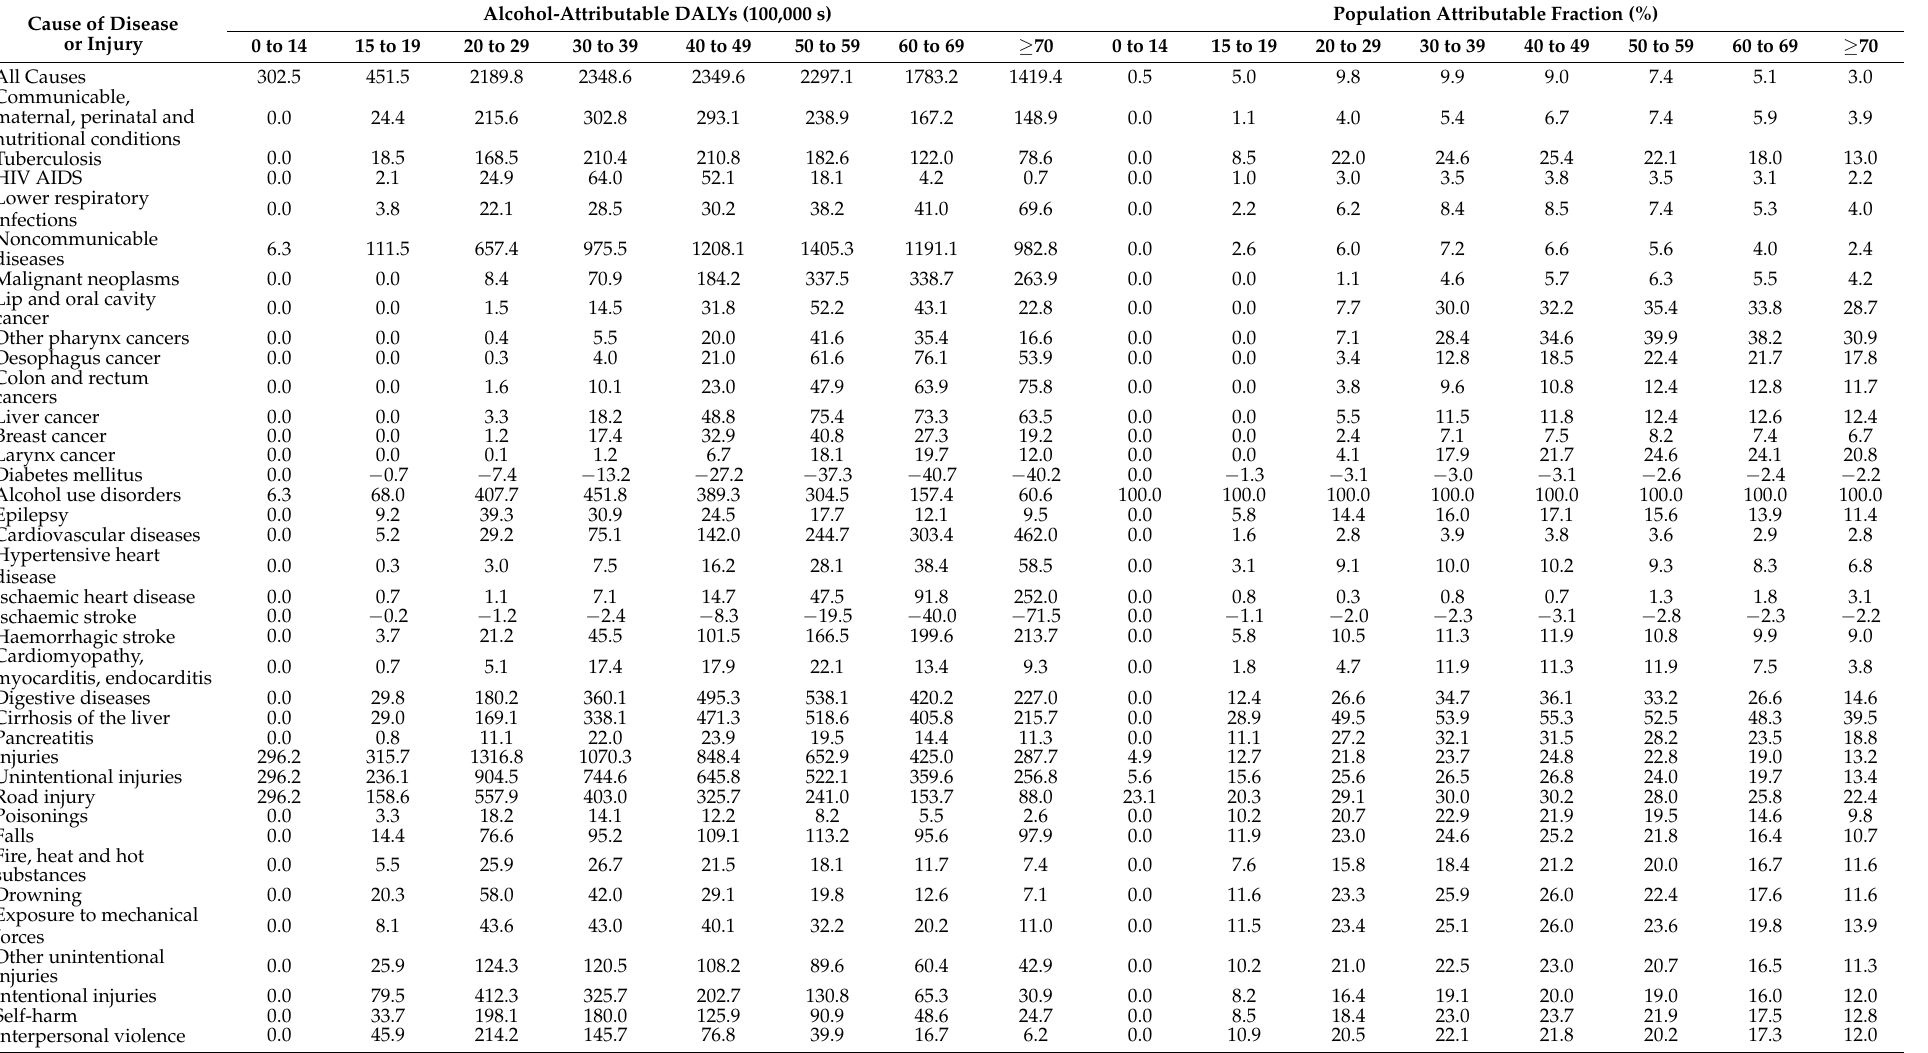
Table 2. Alcohol-attributable disability adjusted life years lost globally in 2016, by cause for people 0 to 69 years of